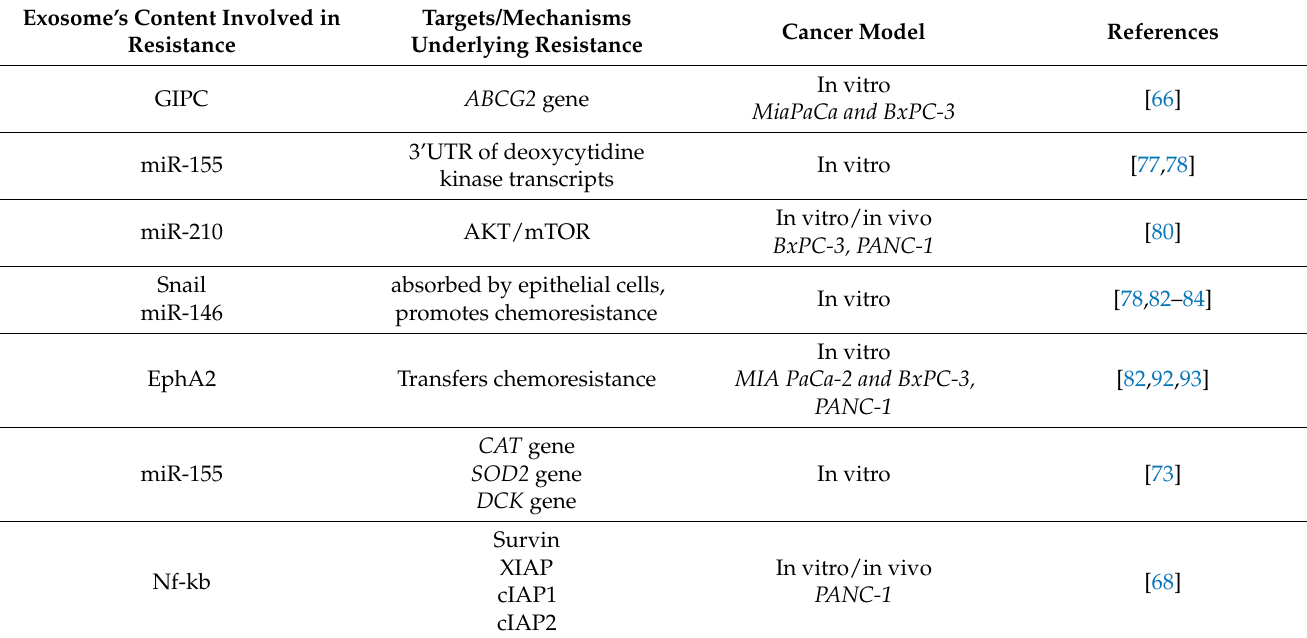
Table 1. Exosome-mediated mechanisms of resistance to